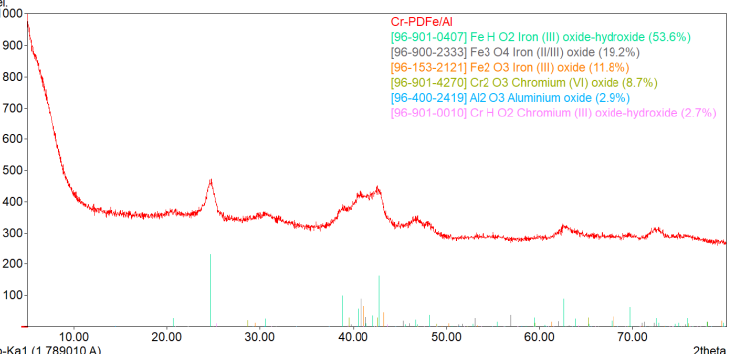
Figure 3. XRD diffractogram of the PDFe/Al after Cr(VI) adsorption. Error between selected phases and experimental profile = 3.4%.